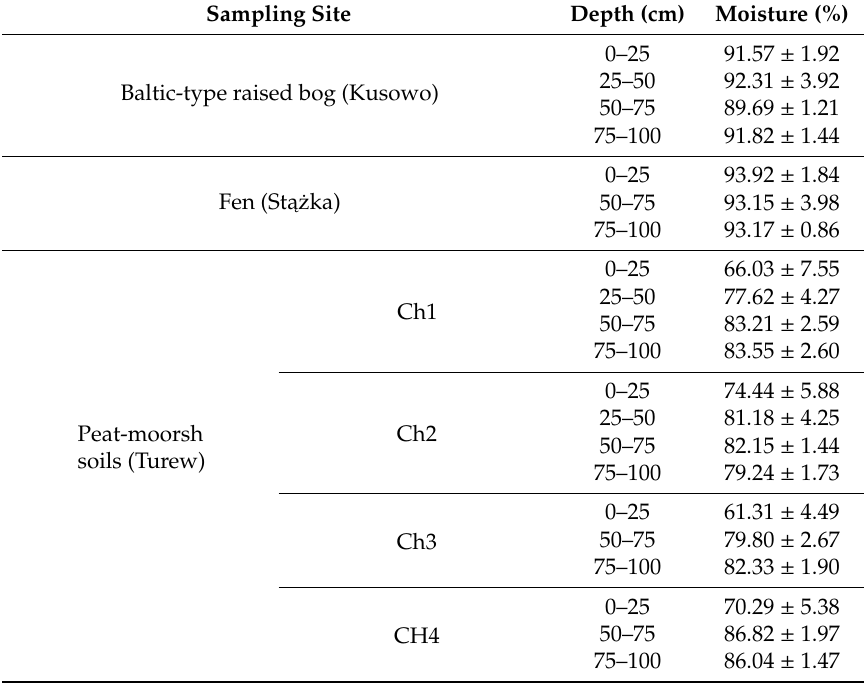
Table 5. Moisture content of sampling